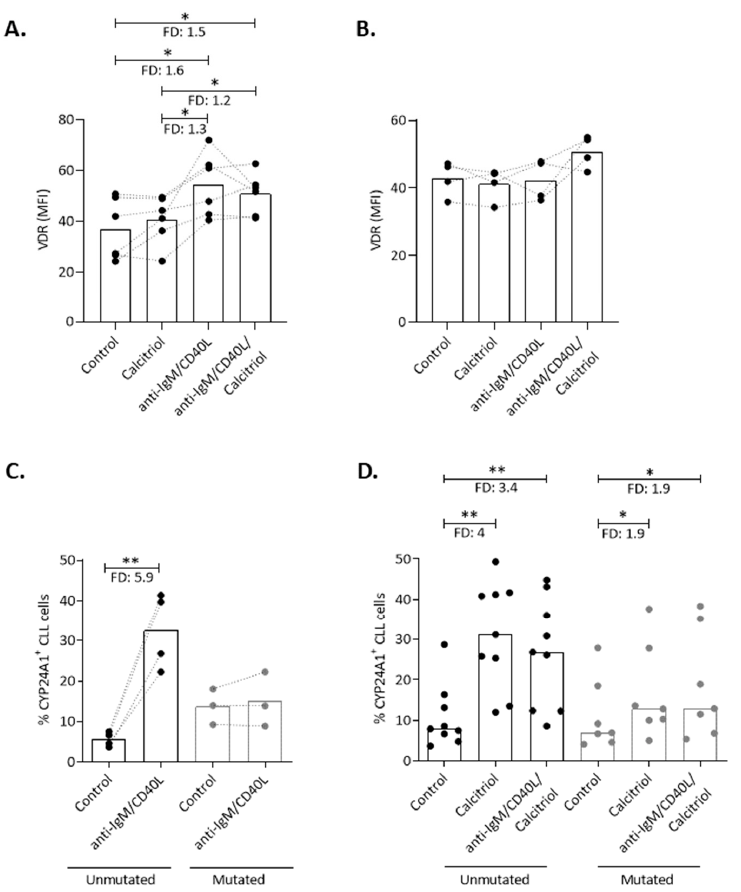
Figure 4. Immune signals affect VDR/calcitriol system, yet calcitriol action remains unaffected. Flow cytometric analysis of VDR (MFI) in ( A ) CLL with unmutated IGHV genes (U-CLL) and ( B ) CLL with mutated IGHV genes (M-CLL) cases treated with calcitriol, anti-IgM/CD40L, and a com- bination of them for 24 h. ( C ) Flow cytometric analysis of CYP24A1 expression in U-CLL and M-CLL cells treated with anti-IgM/CD40L for 24 h. ( D ) U-CLL and M-CLL cases were incubated with calcitriol and combination of anti-IgM/CD40L/calcitriol for 24 h. The percentage of CYP24A1 + CLL cells was determined by flow cytometry. ( A – D ) Bars represent the median values and the Wil- coxon test was performed to assess statistical significance. * p < 0.05, ** p < 0.01, FD: Fold Differ- ence.